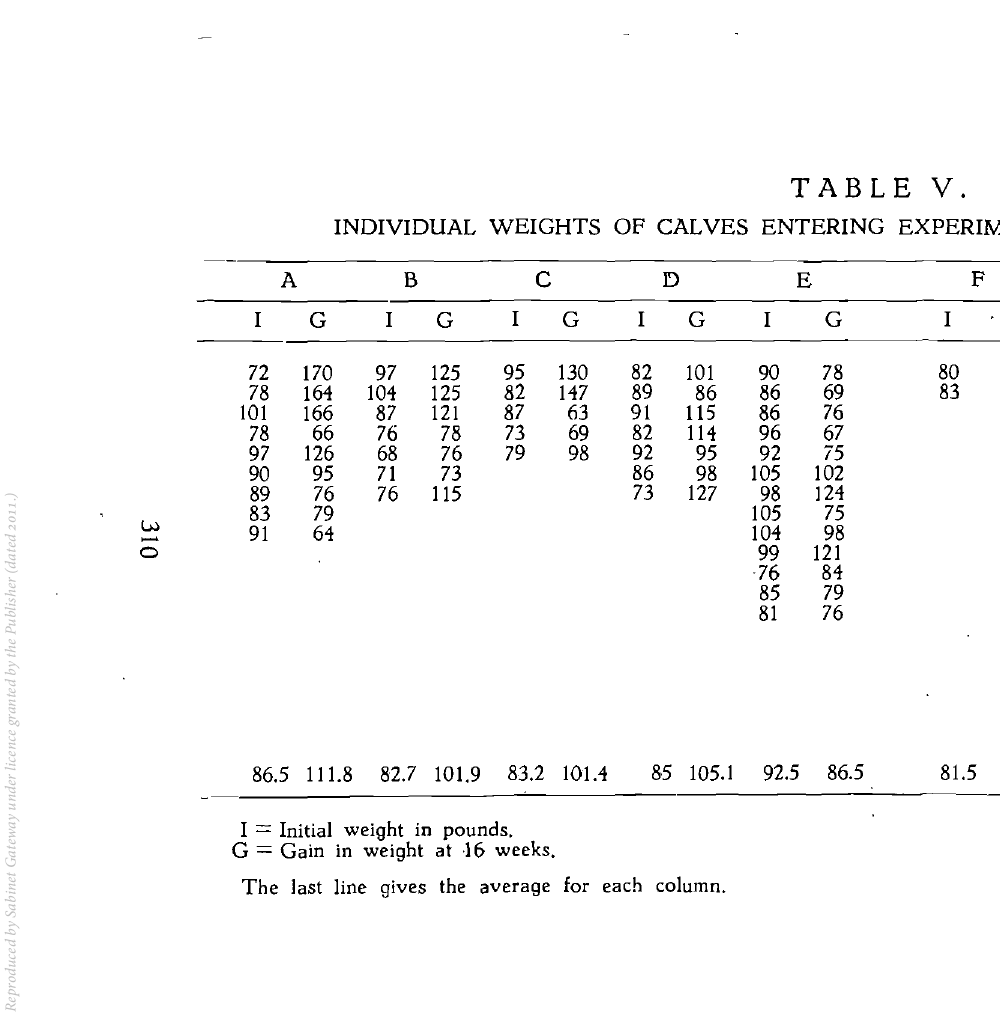
I = Initial weight in pounds. G = Gain in weight at 16 weeks. The last line gives the average for each